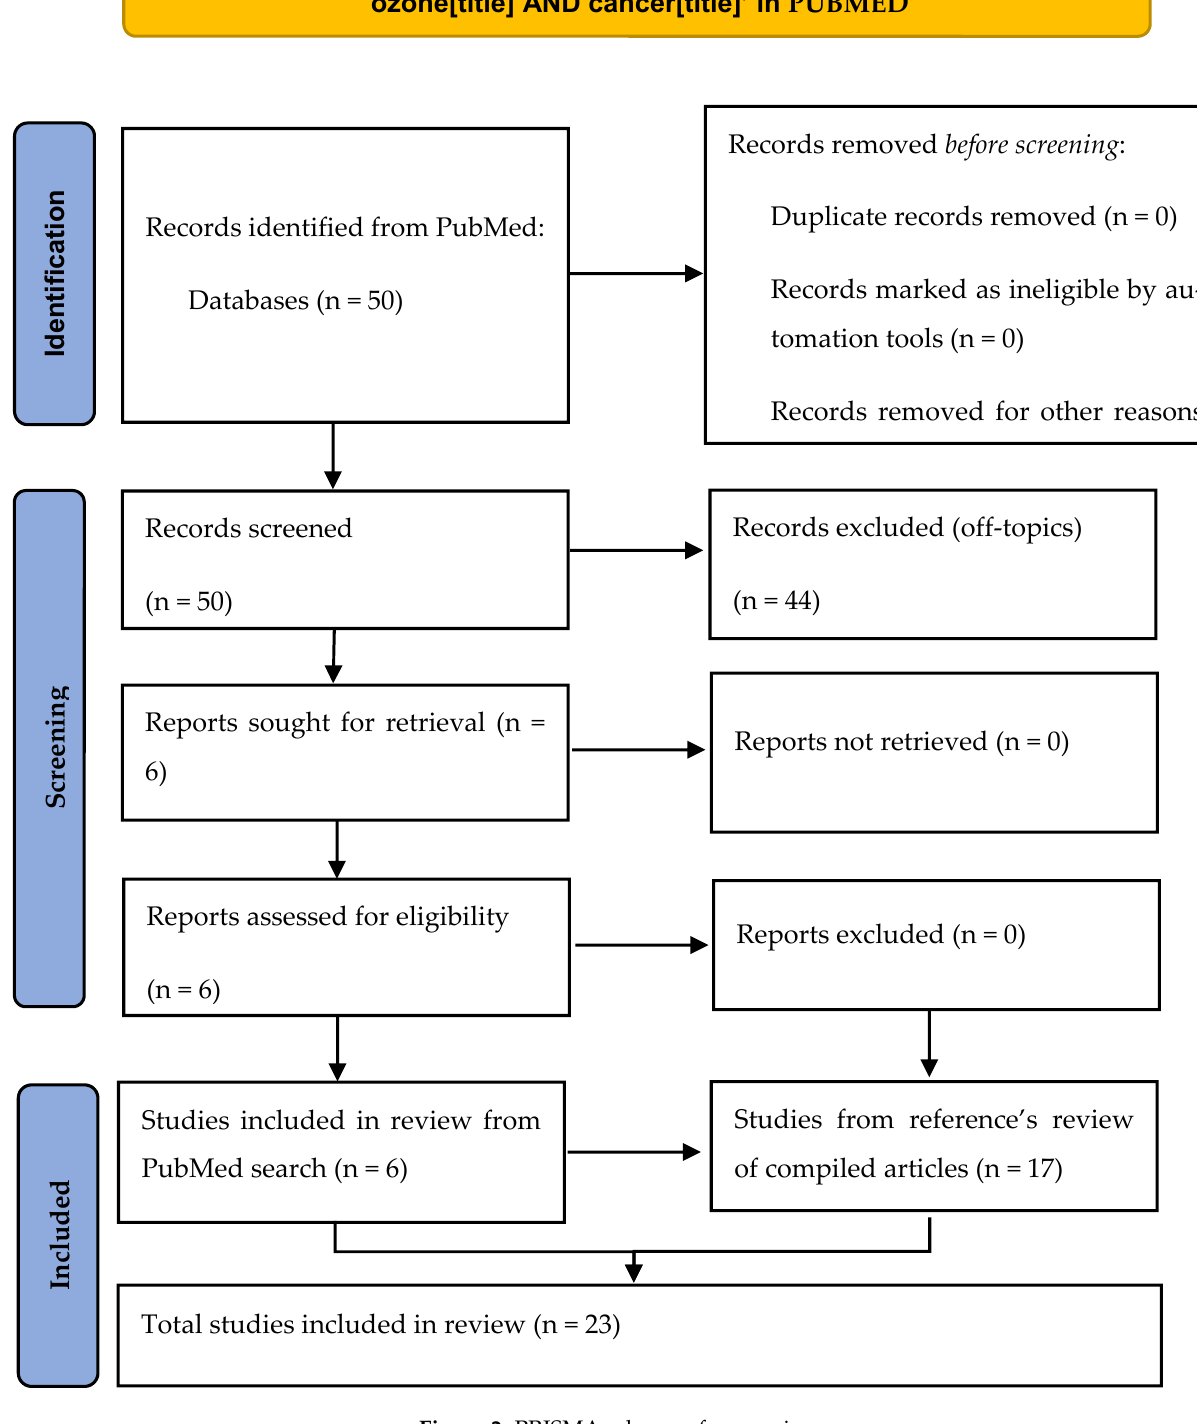
Figure 2. PRISMA scheme of our review.